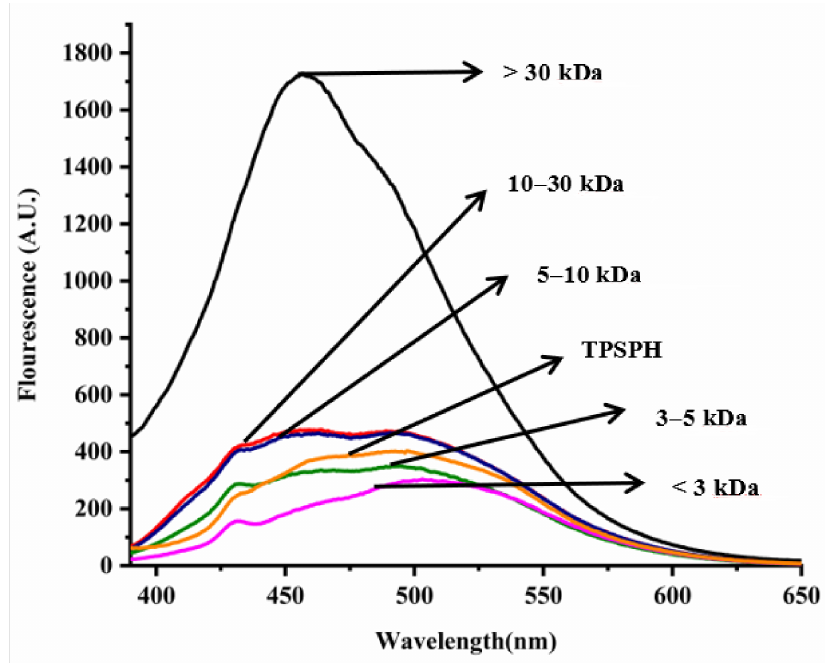
Figure 3. Surface hydrophobicity of TPSPH and five